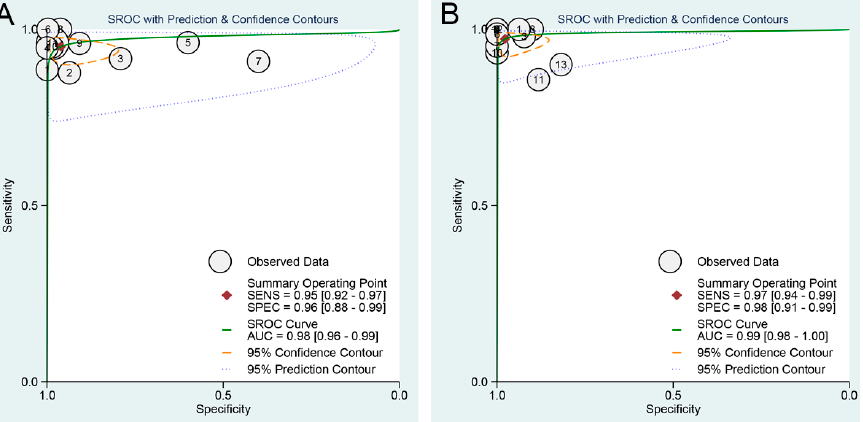
Figure 4. Summary receiver operating characteristic curves showing the pooled sensitivity and specificity of ( A ) ICA- and ( B ) NAIA-based POCTs in diagnosis of PEDV.